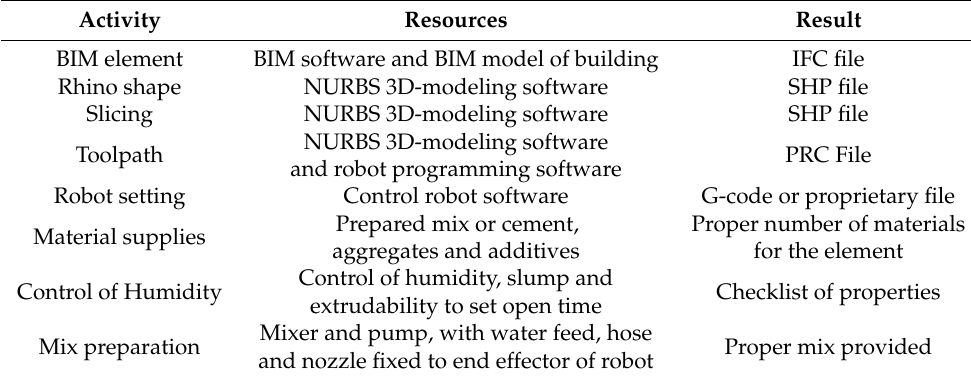
Table 3. Tasks developed for 3D-printed